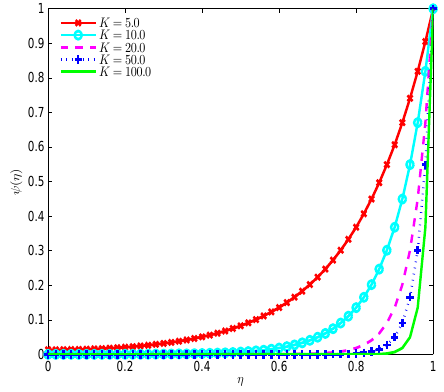
Fig. 9: Variation of f with γ at α = 0.01 , β = 0.005 , Re = 10.0 , K = 10.0 and Λ = 0.001 .